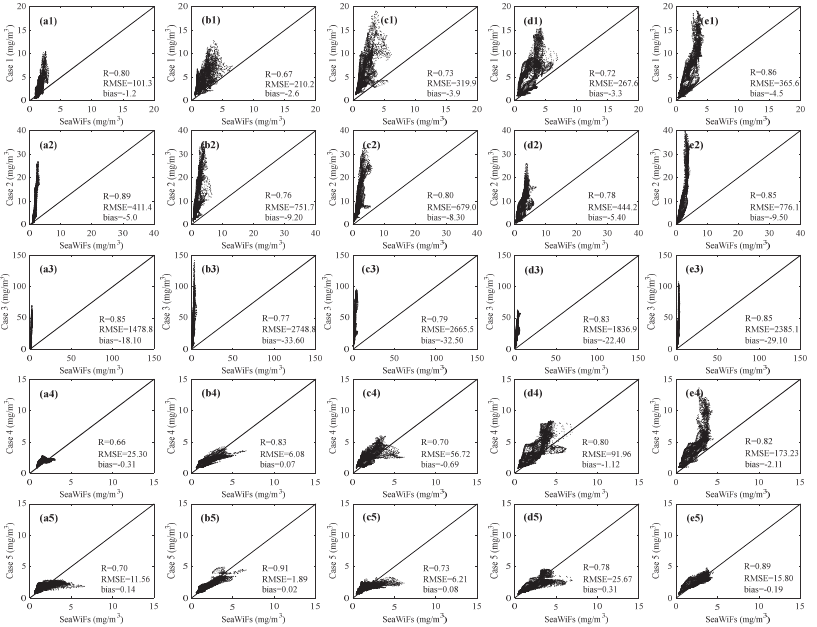
Figure 5. Comparisons of chlorophyll from model (five cases) against SeaWiFS from April to August (13 ‐ year average from 1998–2010) within the area of 29° N–32° N and 122.5° E–124° E. The figures in the first row ( a1 – e1 ) are for Case 1 and SeaWiFS. The figures in the second row ( a2 – e2 ) are from Case 2 and SeaWiFS. The figures in the third row ( a3 – e3 ) are from Case 3 and SeaWiFS. The figures in the fourth row ( a4 – e4 ) are from Case 4 and SeaWiFS. The figures in the fifth row ( a5 – e5 ) are from Case 5 and SeaWiFS. The correlation coefficient (R), root mean square error (RMSE) and bias between model and SeaWiFS are shown in each